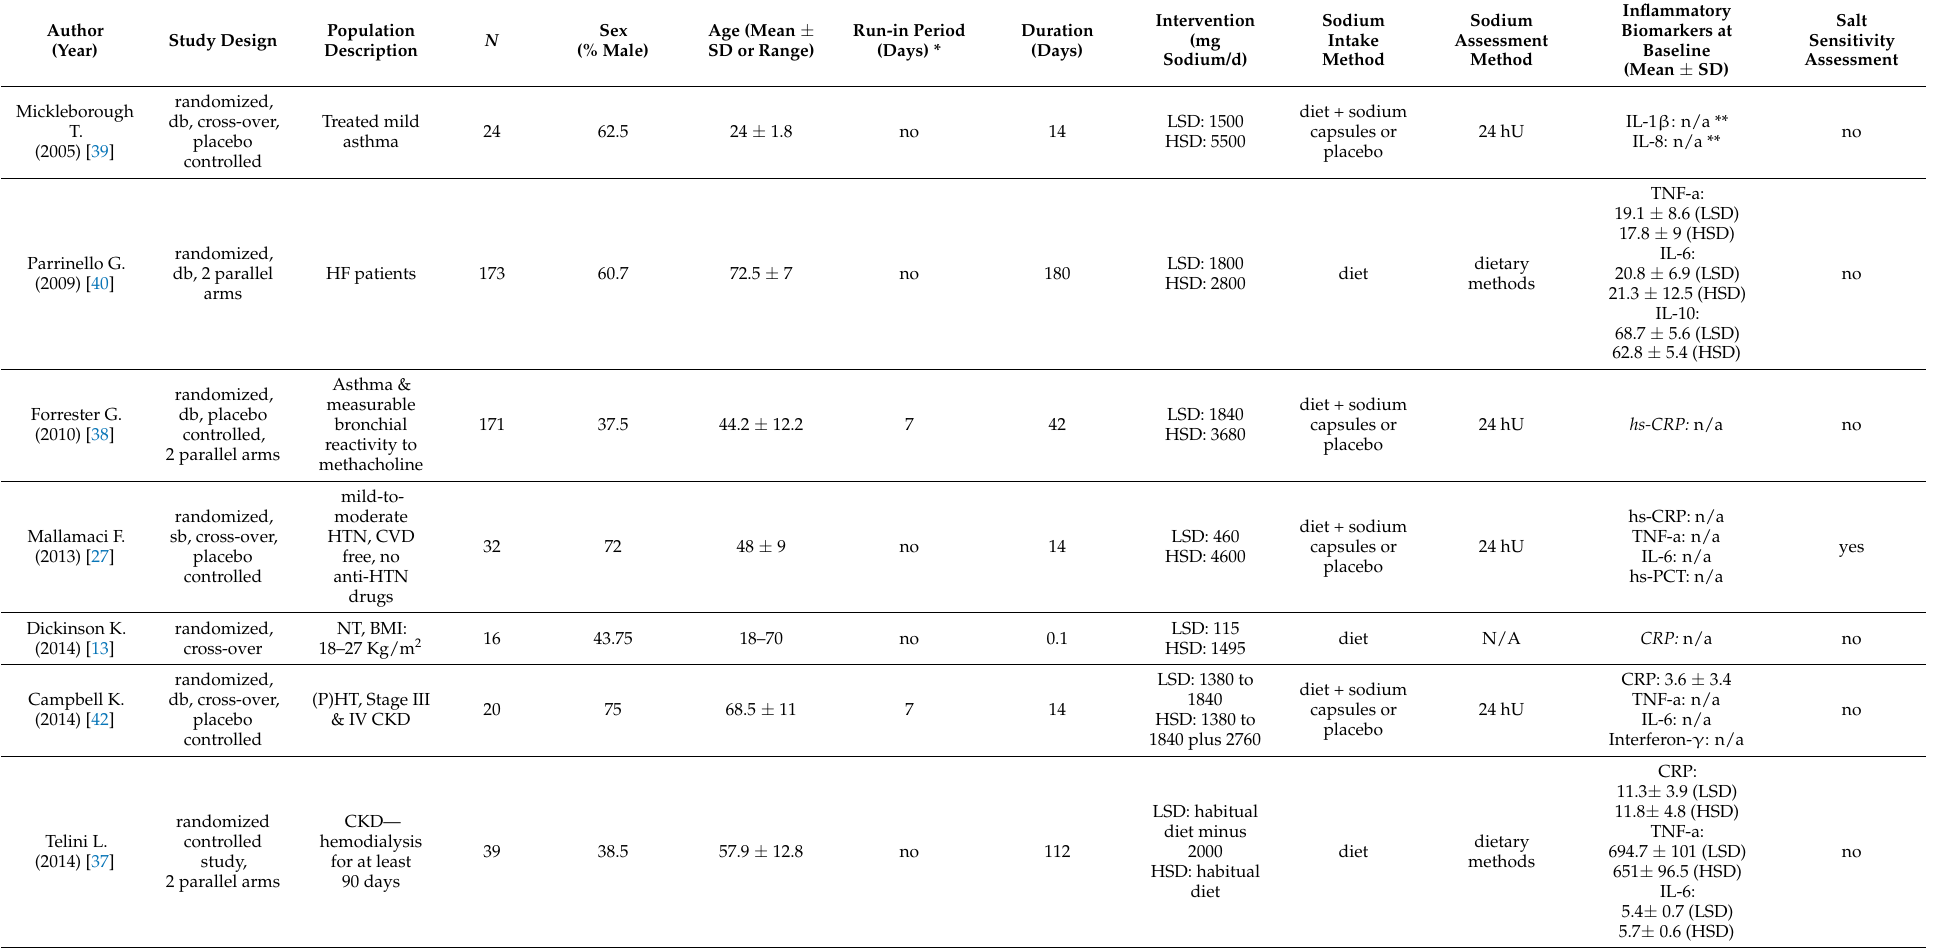
Table 1. Descriptive characteristics of all of the selected studies ( n =